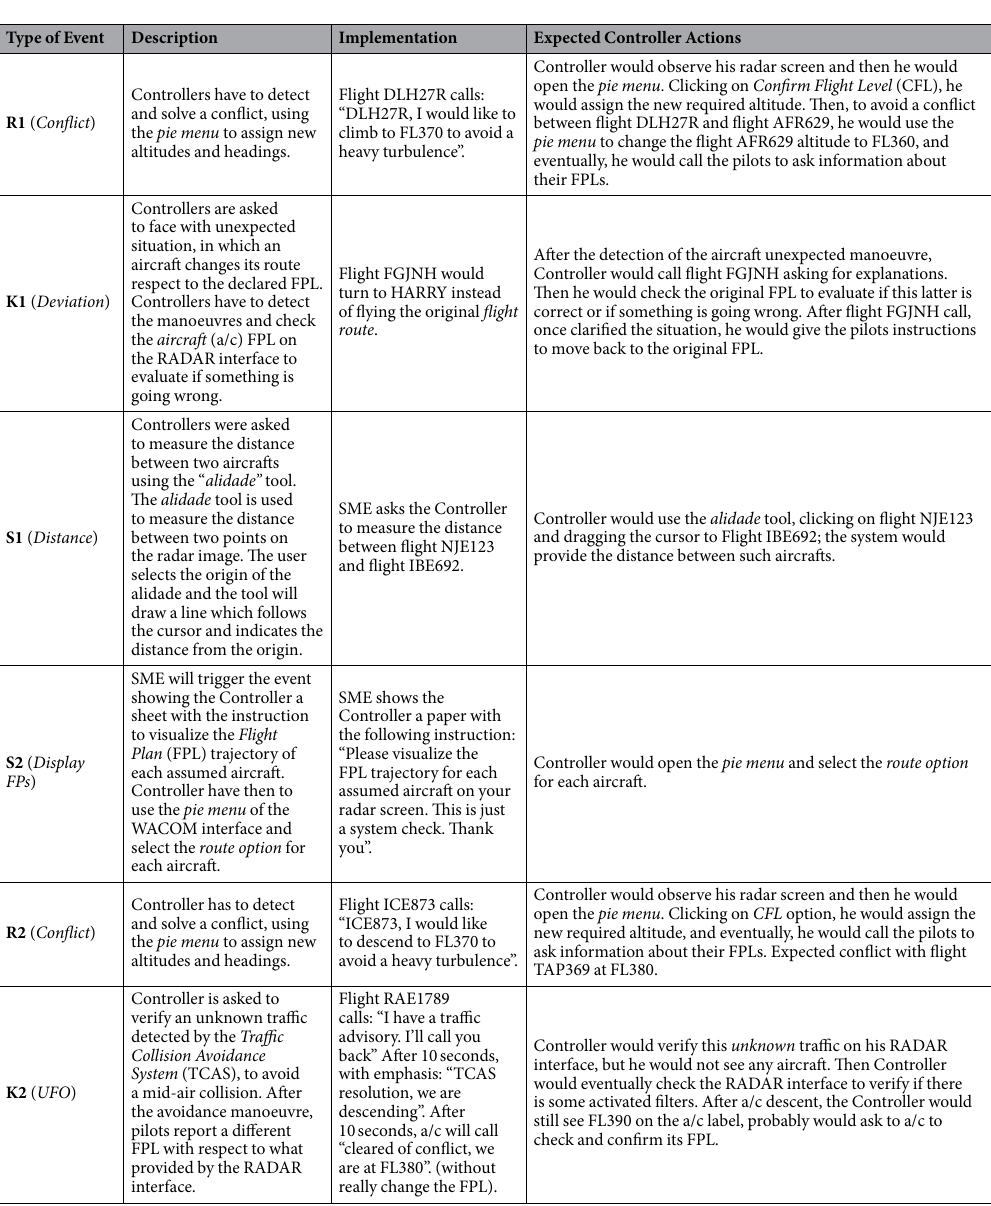
Table 2. Detailed descriptions of the six SRK events designed to induce Skill, Rule and Knowledge behaviours in the Controllers during the execution of the ATM